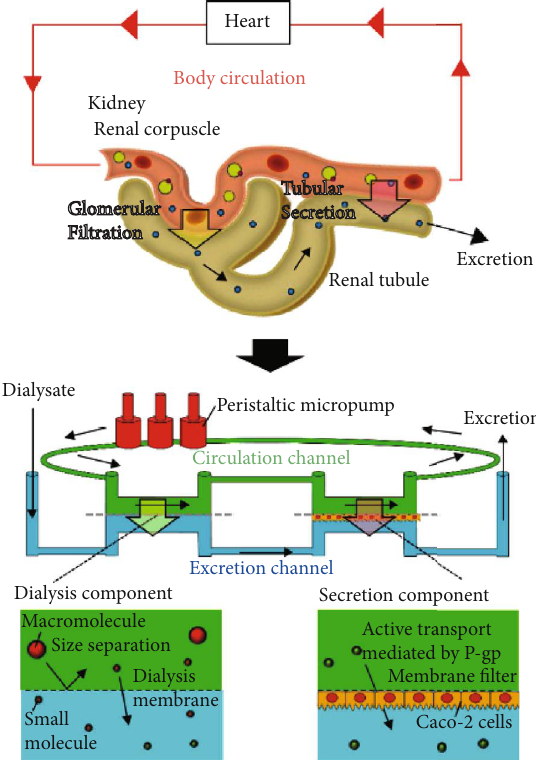
Figure 6: Renal excretion in the human body and the micro fl uidic kidney model which mimics the glomerular fi ltration and tubular secretion in the kidney. Reproduced (or adapted) with permission [45], ©2018,